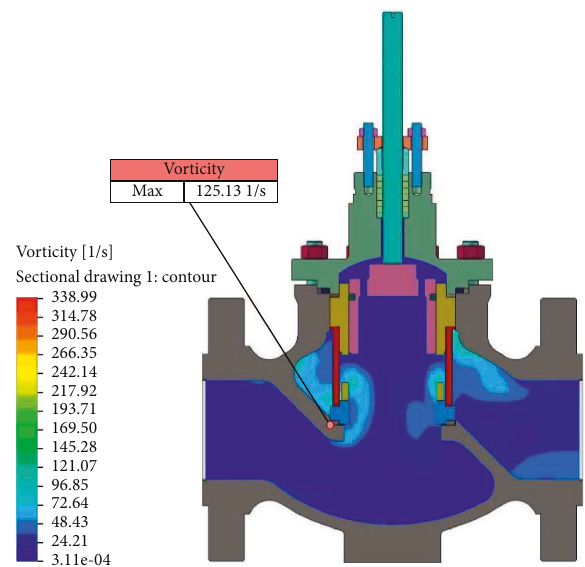
Figure 14: Speed cloud map for 100% opening.